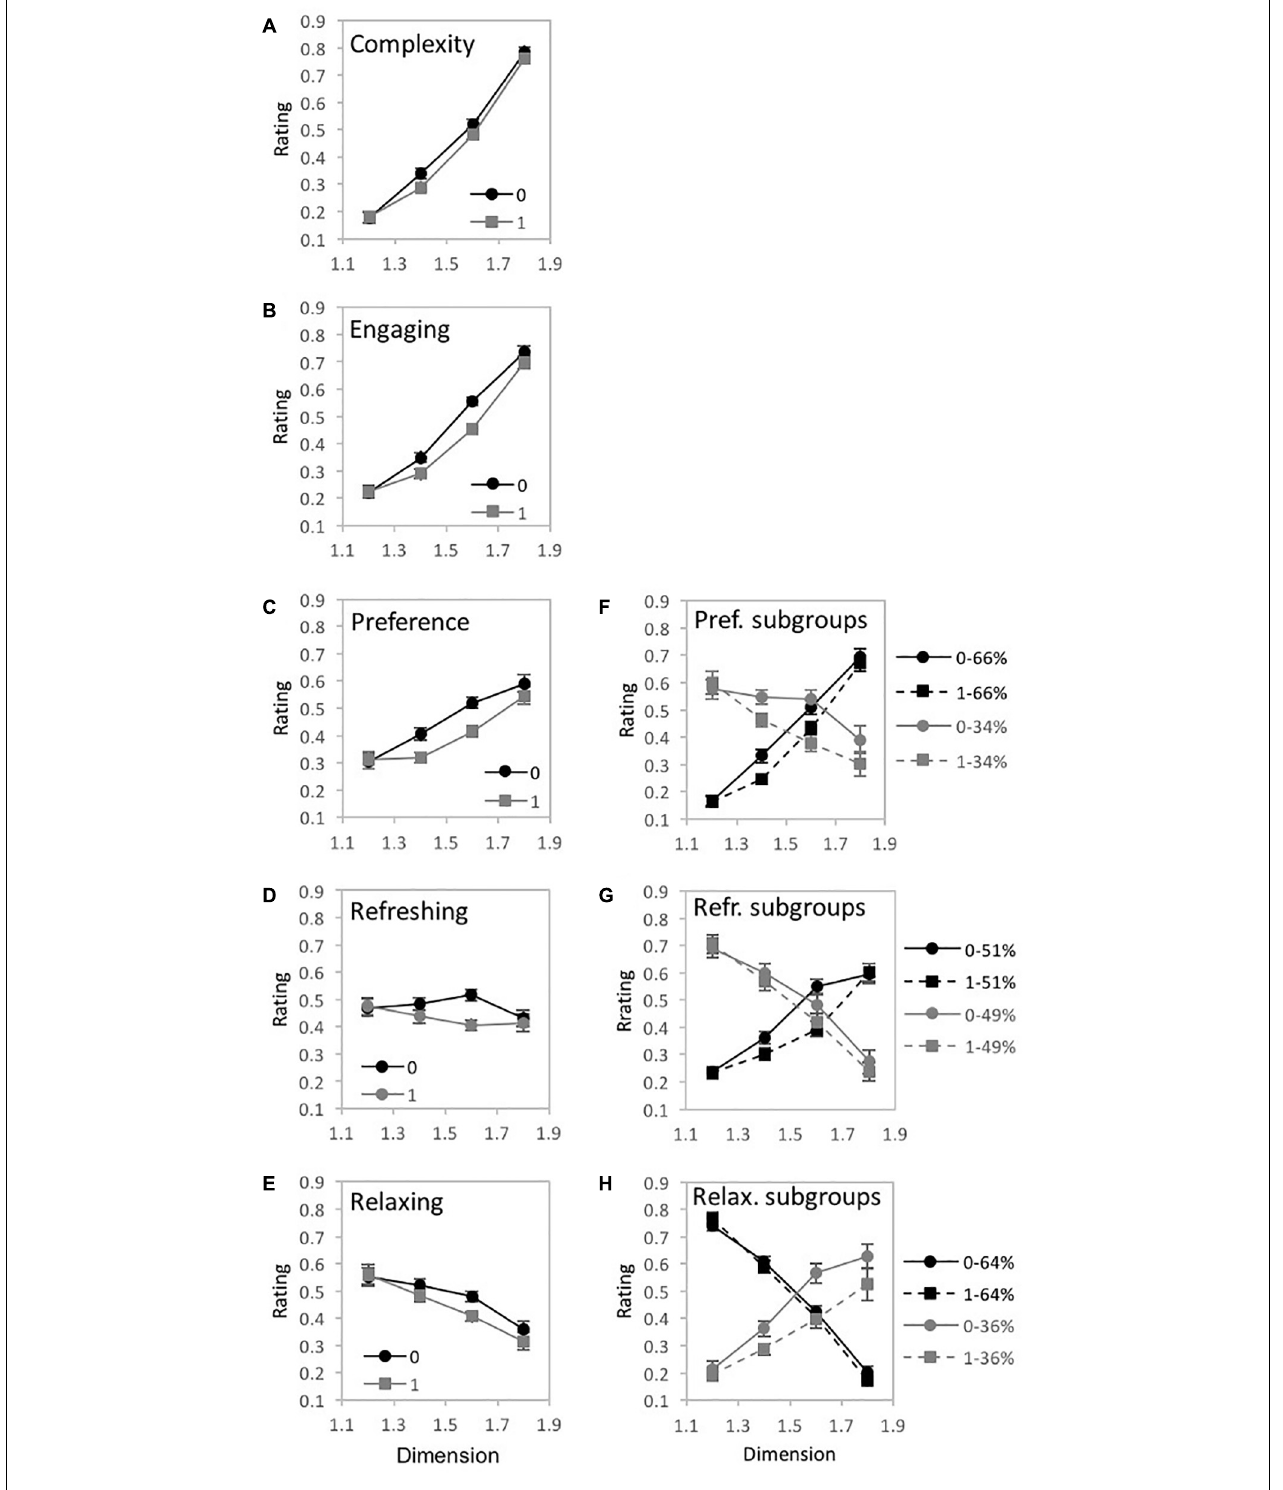
FIGURE 7 | Experiment 1A results for “global forest” fractal patterns for 5 different judgment conditions (how complex, engaging, preferred, refreshing, and relaxing). (A–E) shows plots of mean ratings as a function of fractal dimension ( D ) and 2 pattern arrangements (not randomized “0,” randomized “1”) for the different judgment conditions (error bars represent standard error). (F–H) shows plots of mean ratings as a function of fractal dimension ( D ) and 2 pattern arrangements (not randomized “0,” randomized “1”) for each subpopulation identified with cluster analysis (error bars represent standard error).